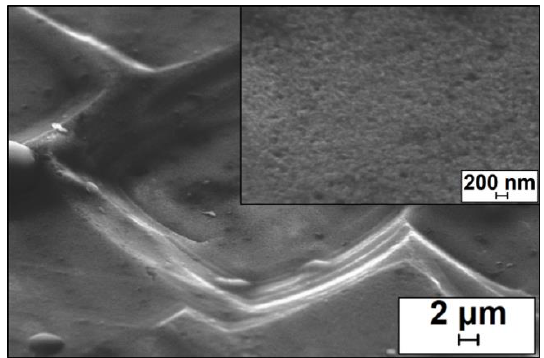
Figure 4. SEM image of the 5 s etched unpolished side of Si wafer after Ag nanoparticle removal (inset: magnified image showing the formation of nano-structured pits over the Si surface).